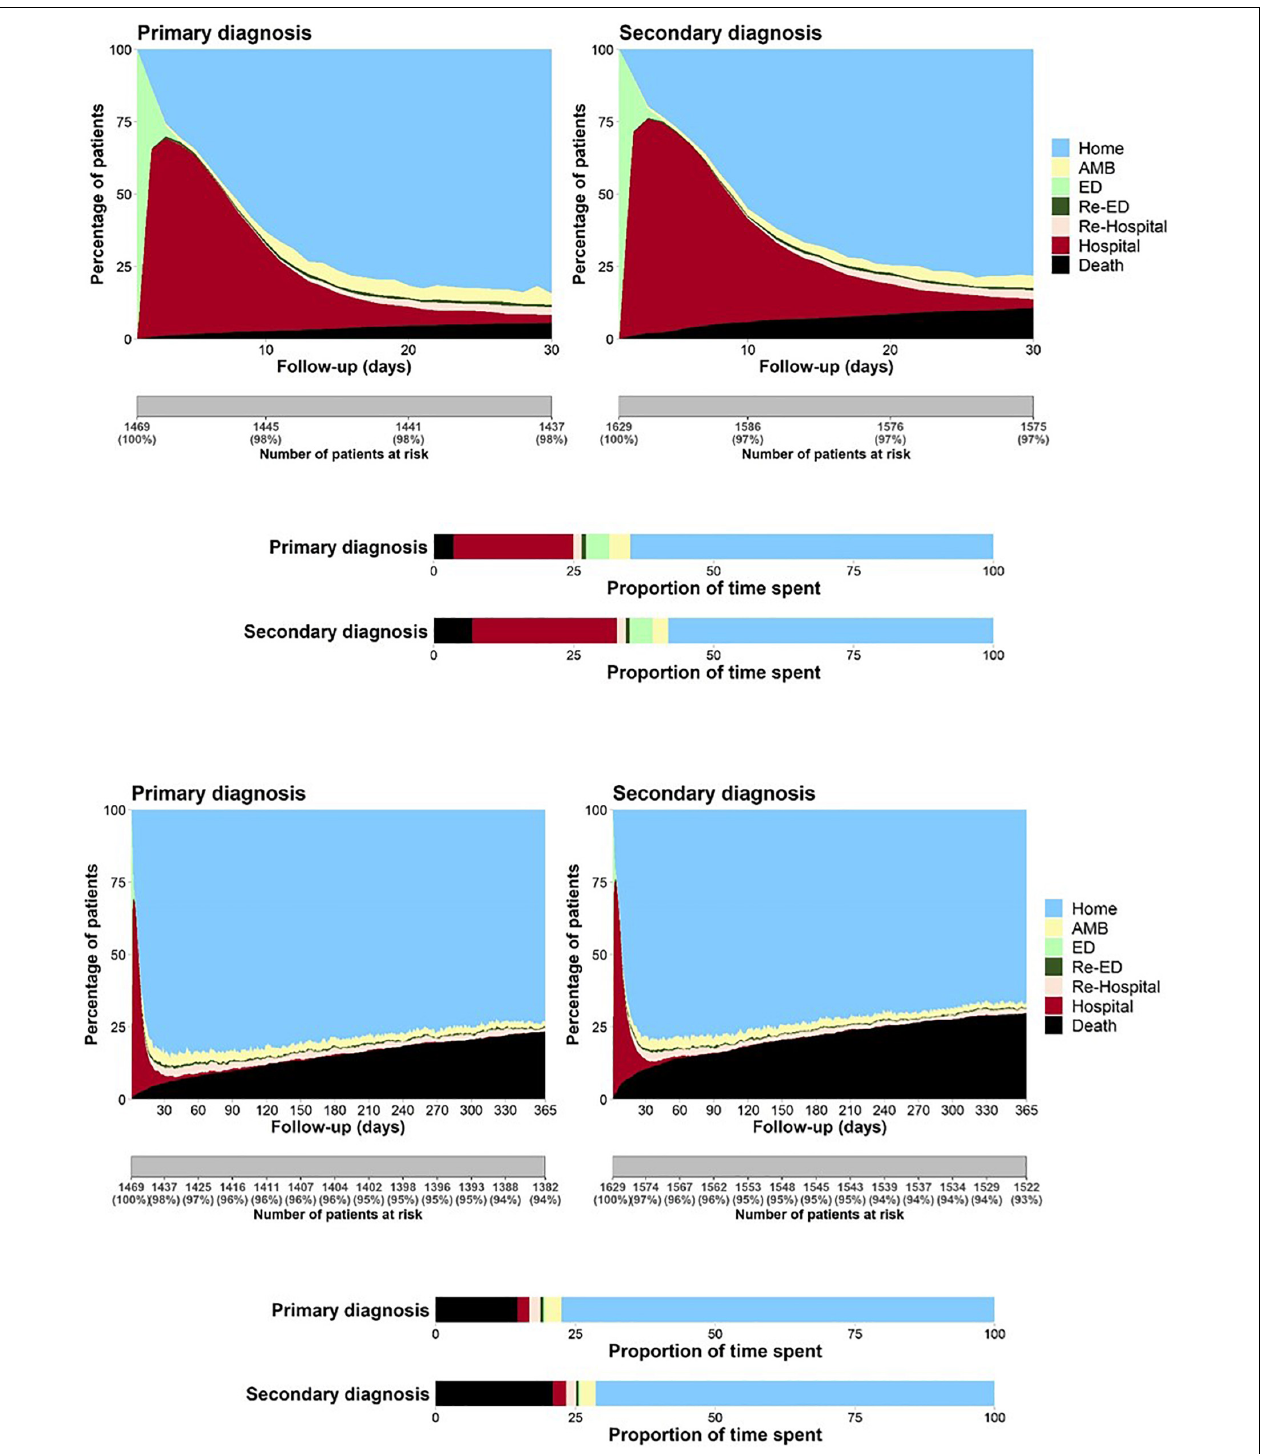
FIGURE 2 | The 30-day (top) and 1-year (down) composite outcomes using the COHERENT model according to the type of heart failure diagnosis: primary (left) and secondary (right). The black area represents mortality. The light green area on the left side of each figure represents the time spent in the first emergency department (ED) visit, the brown area represents the time spent in the first hospitalization, the light blue area in the top right corner represents the time spent at home. The days with one outpatient office visit, the number of days with subsequent ED visits, or the days spent in the hospital during re-hospitalizations are represented by the light yellow, dark green, and light brown areas, respectively. The proportion of time spent in each clinical condition can be compared in the display in the horizontal bars shown below.